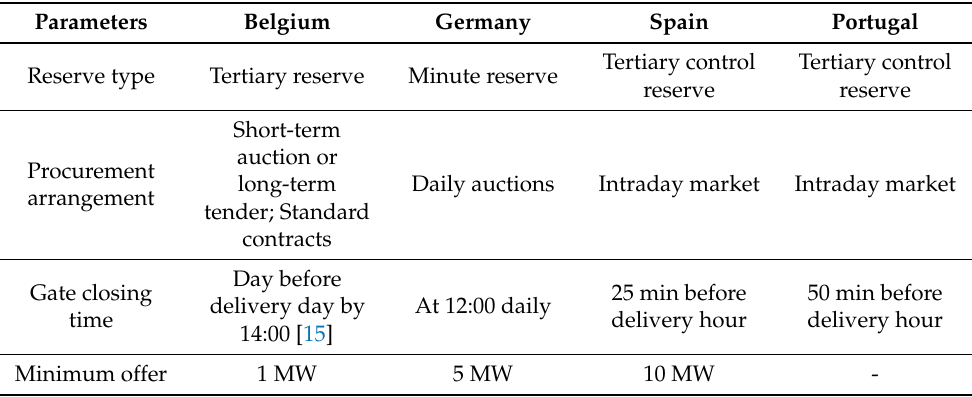
Table 6. Summary of FRR-M and RR services unified under the ENTSO-E classification, including Belgium, Germany, Spain and Portugal.